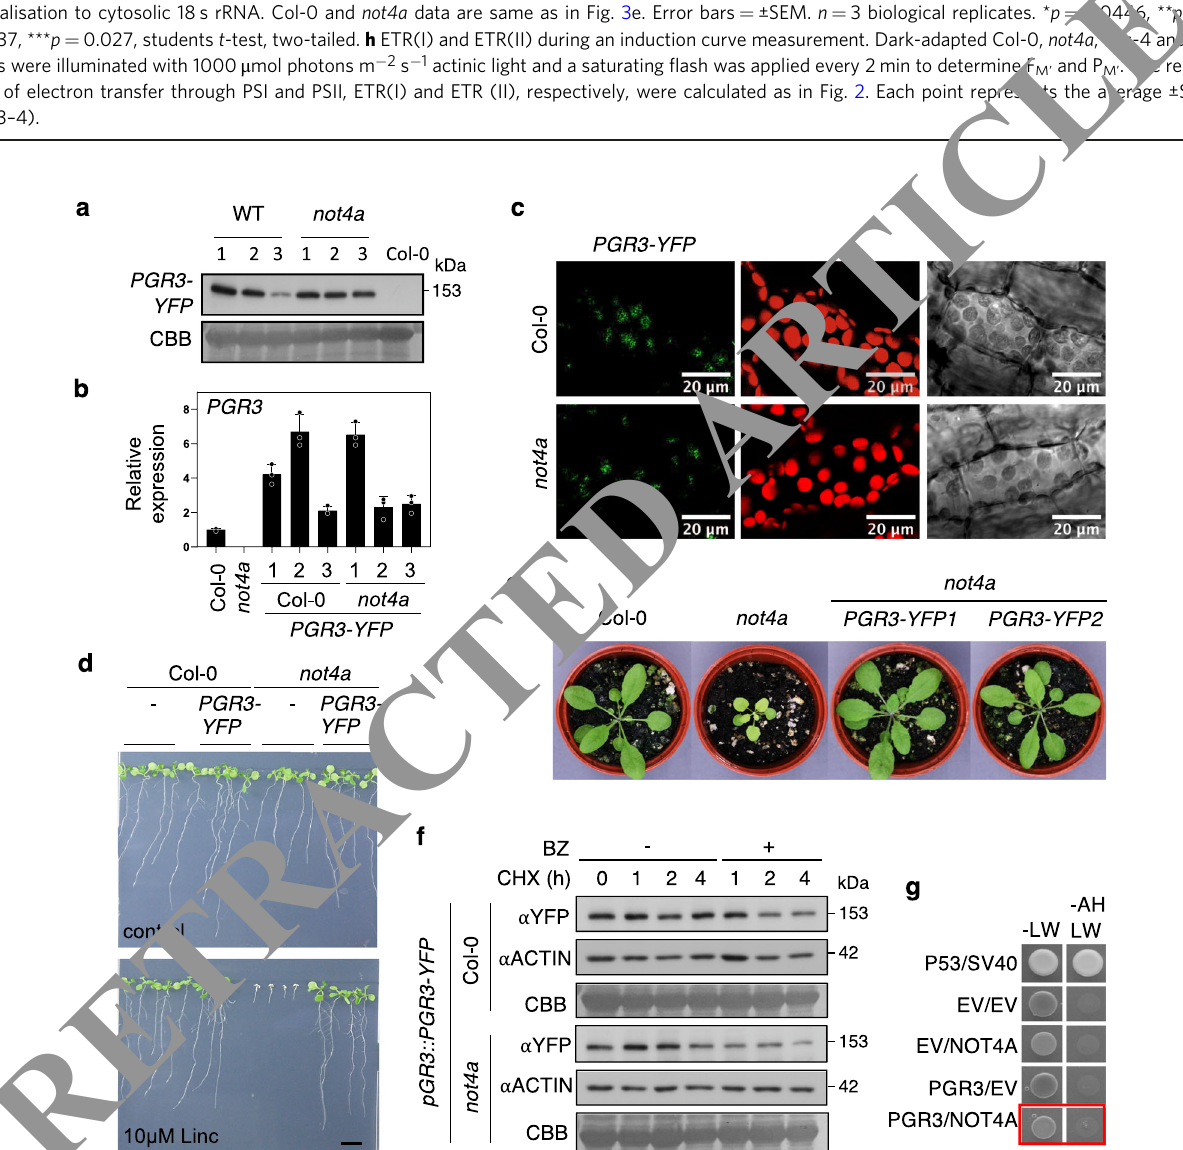
NATURE COMMUNICATIONS| (2021) 12:251